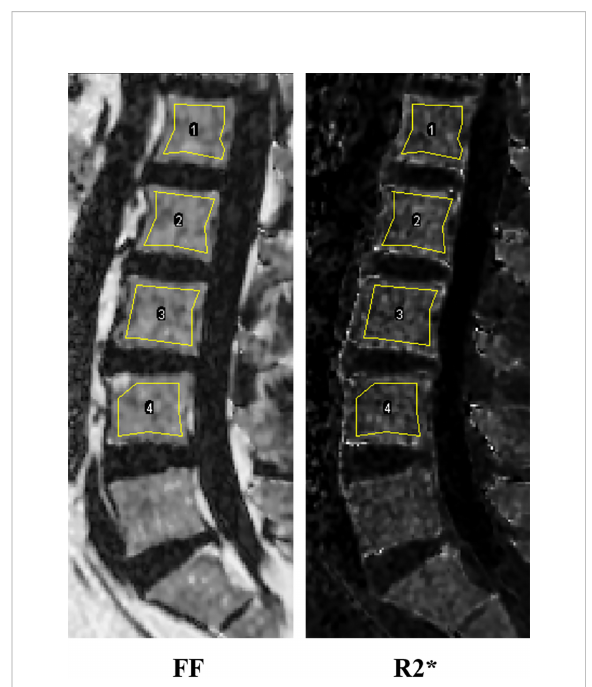
FIGURE 2 Representative IDEAL-IQ images and ROI of the lumbar spine (from L1 to